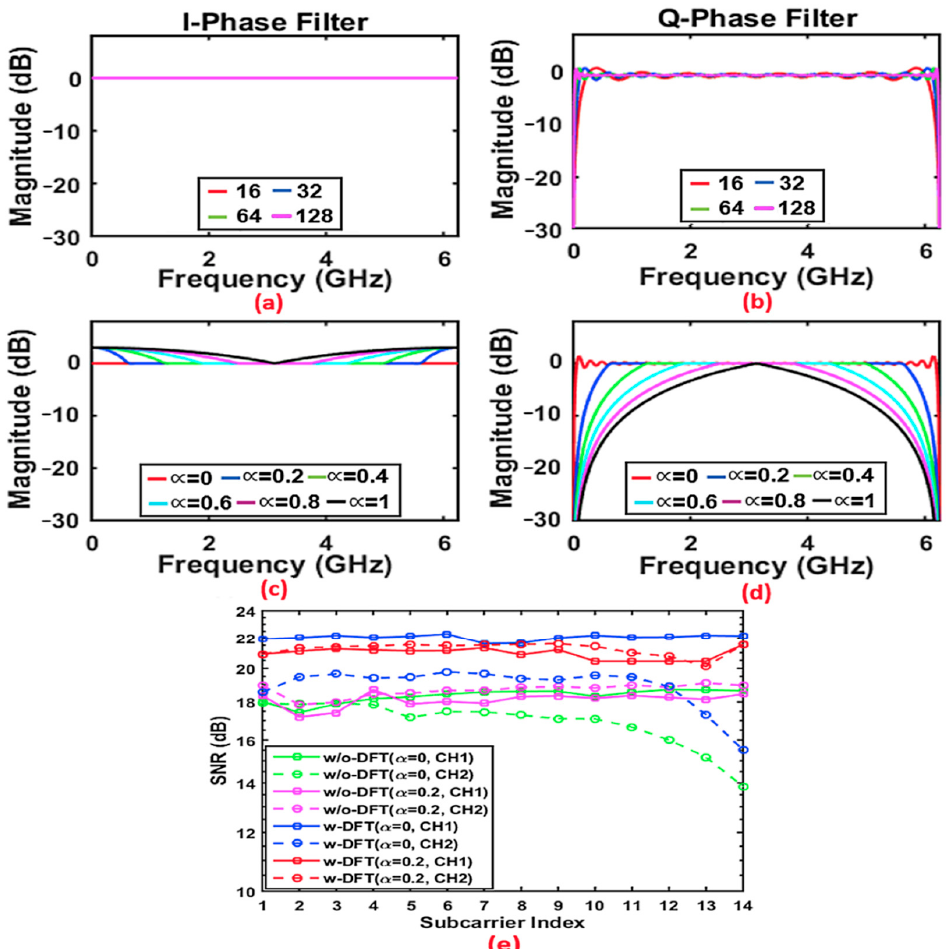
Figure 7. Magnitude response for excess of bandwidth of α = 0 for ( a ) I-phase filter with digital filter lengths 16, 32, 64, and 128; ( b ) Q-phase filter with digital filter lengths 16, 32, 64, and 128. Magnitude response for filter length 64 for ( c ) I-phase filter with excess bandwidth ( α ) ranging from 0 to 1, and ( d ) Q-phase filter with excess bandwidth ( α ) ranging from 0 to 1. ( e ) Comparison of SNR distribution across all of the subcarriers, using excess bandwidth of α = 0 and an optimal value of α = 0.2 for both I-phase (CH1) and Q-phase (CH2).